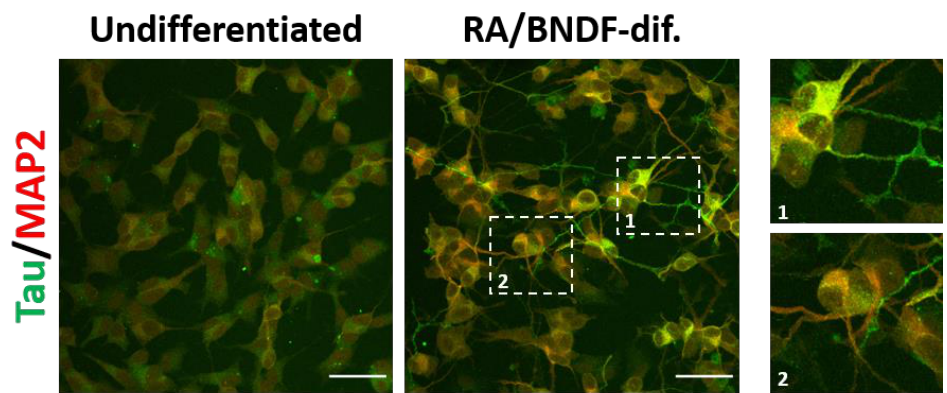
Figure 4. Tau and MAP2 expression and localization in undifferentiated and fully (RA/BDNF) differentiated SH-SY5Y cells (cell source: ECACC). The RA/BDNF differentiation facilitates the enrichment of both microtube-associated proteins, tau and MAP2, respectively. Moreover, two distinct types of neuronal projections, associated with a polarized state of neurons, are observed in fully differentiated SH-SY5Y: axonal-like neurites enriched with tau protein and somato-dendritic compartment consisting of MAP2 (cropped images 1 and 2). Scale bars: 50 µ m. Figure is modified with from [197] with permission of Elsevier, 2022.